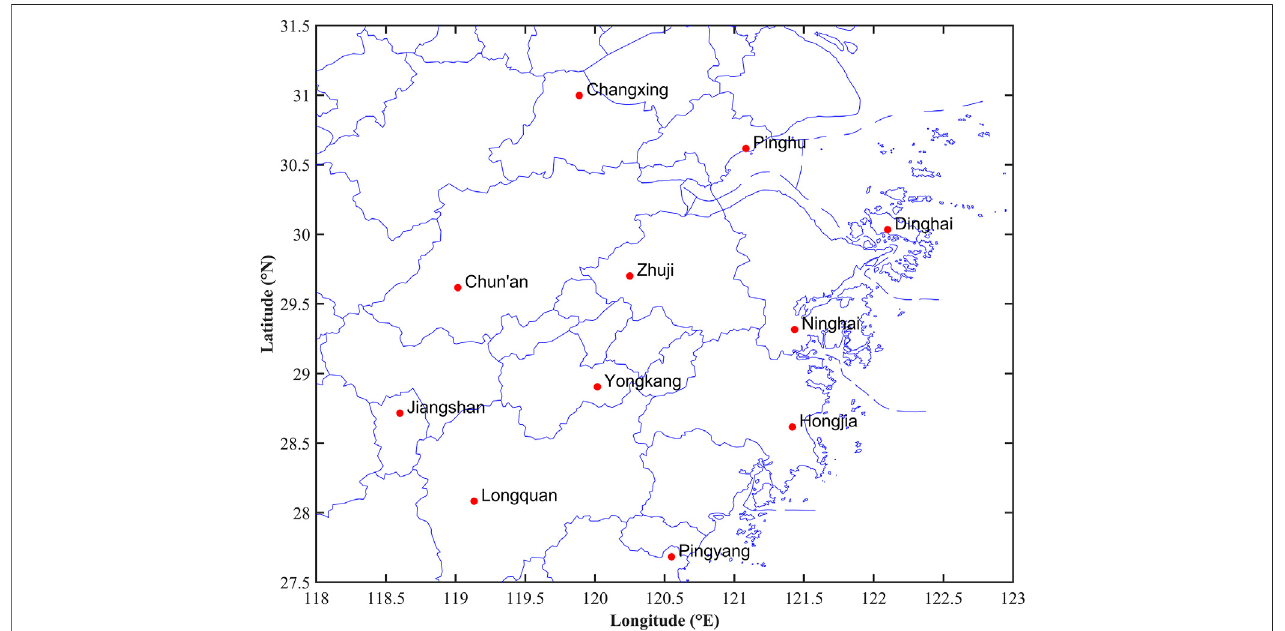
FIGURE 1 | Site distribution map for the lightning location system in Zhejiang